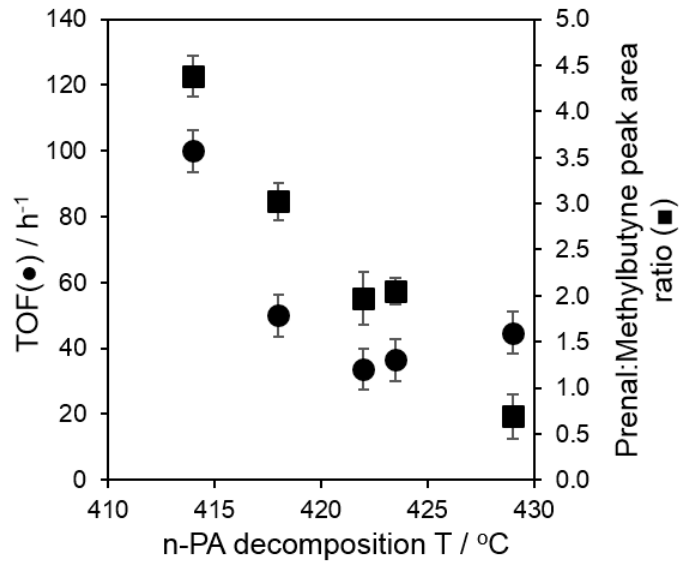
Figure 10. Correlation between TOF for propanoic acid esterification and reactively-formed prenal:methylbutyne ratio over parent and sulfated zirconia as a function of propylamine decomposition temperature.